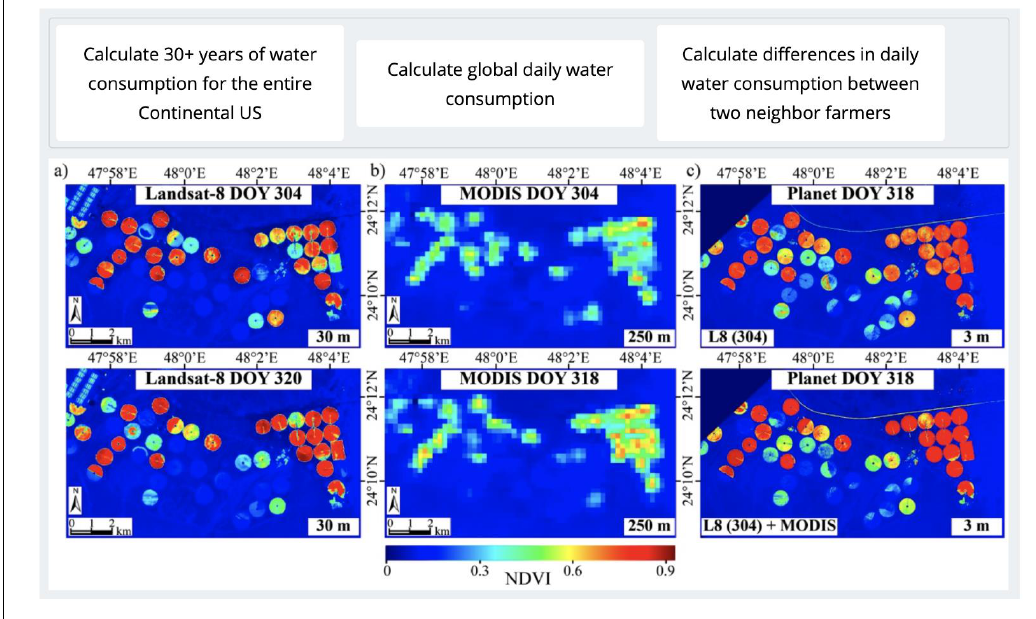
Figure 2. ( a – c ) Example of a drag-and-drop question in Section 3 to test students’ ability to choose the appropriate spatial resolution according to a specific hydrologic application. The images are adopted from Reference [35].